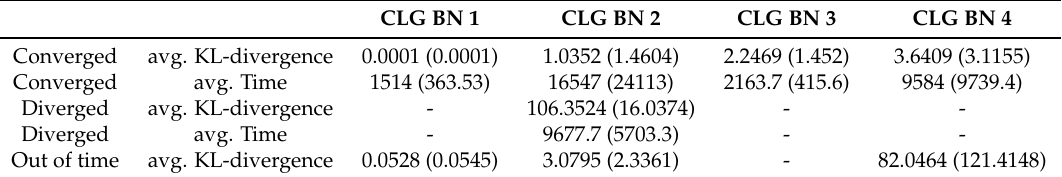
Table 3. Average accuracies and average execution times for the four CLG BNs.